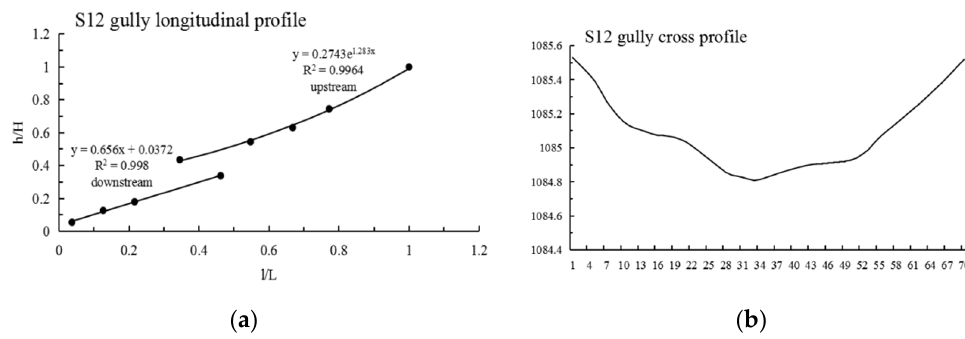
Figure 9. Longitudinal and cross profile fitting diagram of S12.